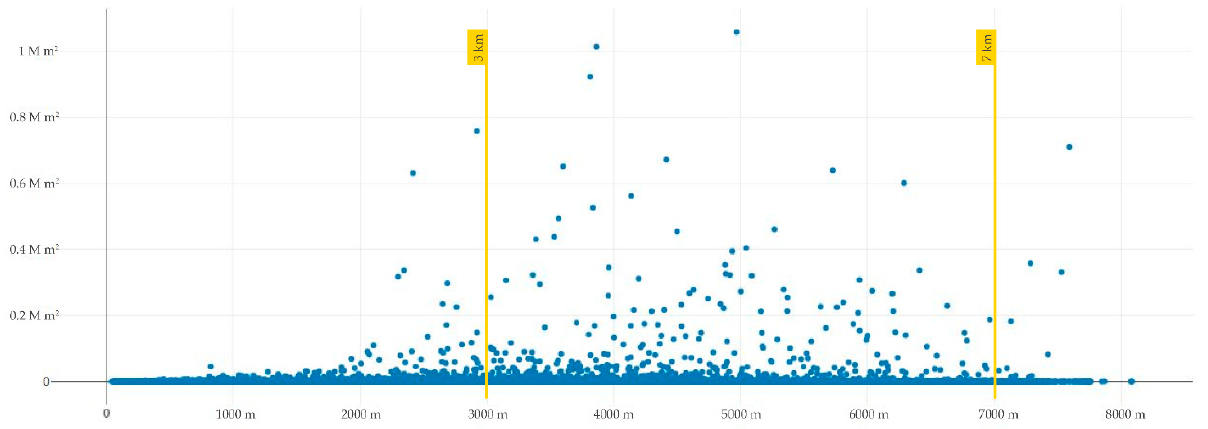
Figure 7. Scatterplot of the distribution of urban green spaces feature dimensions ( y axis, m 2 ) and distance from city centre ( x axis, m).